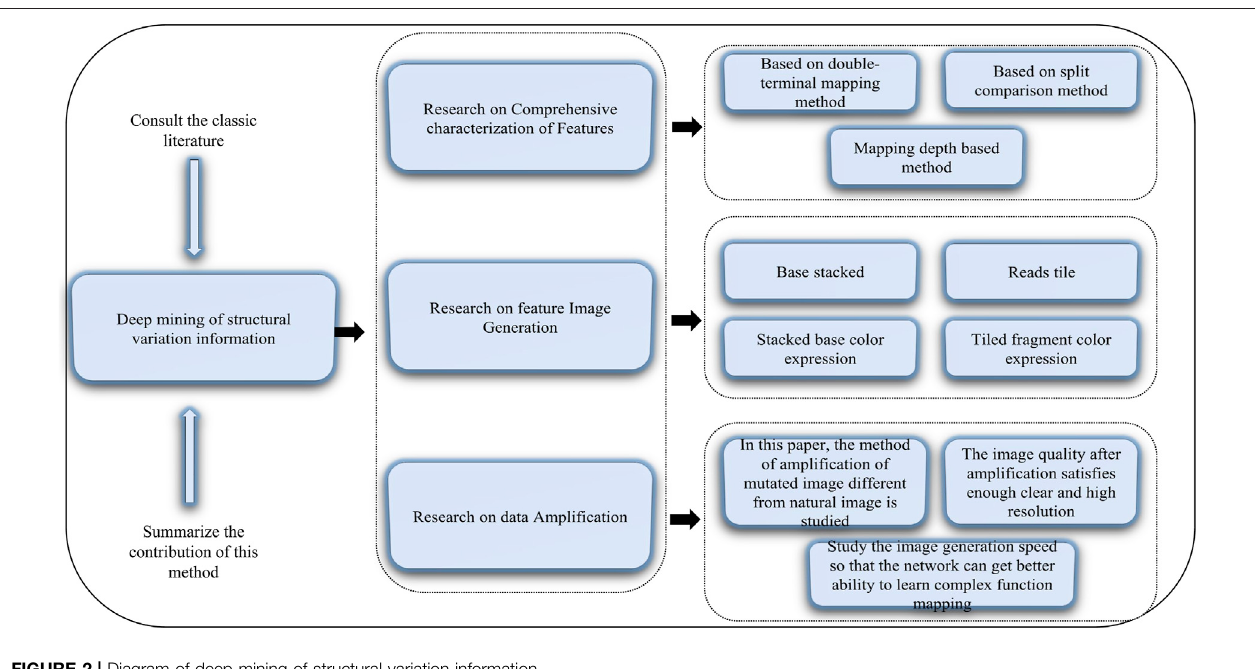
FIGURE 2 | Diagram of deep mining of structural variation information.